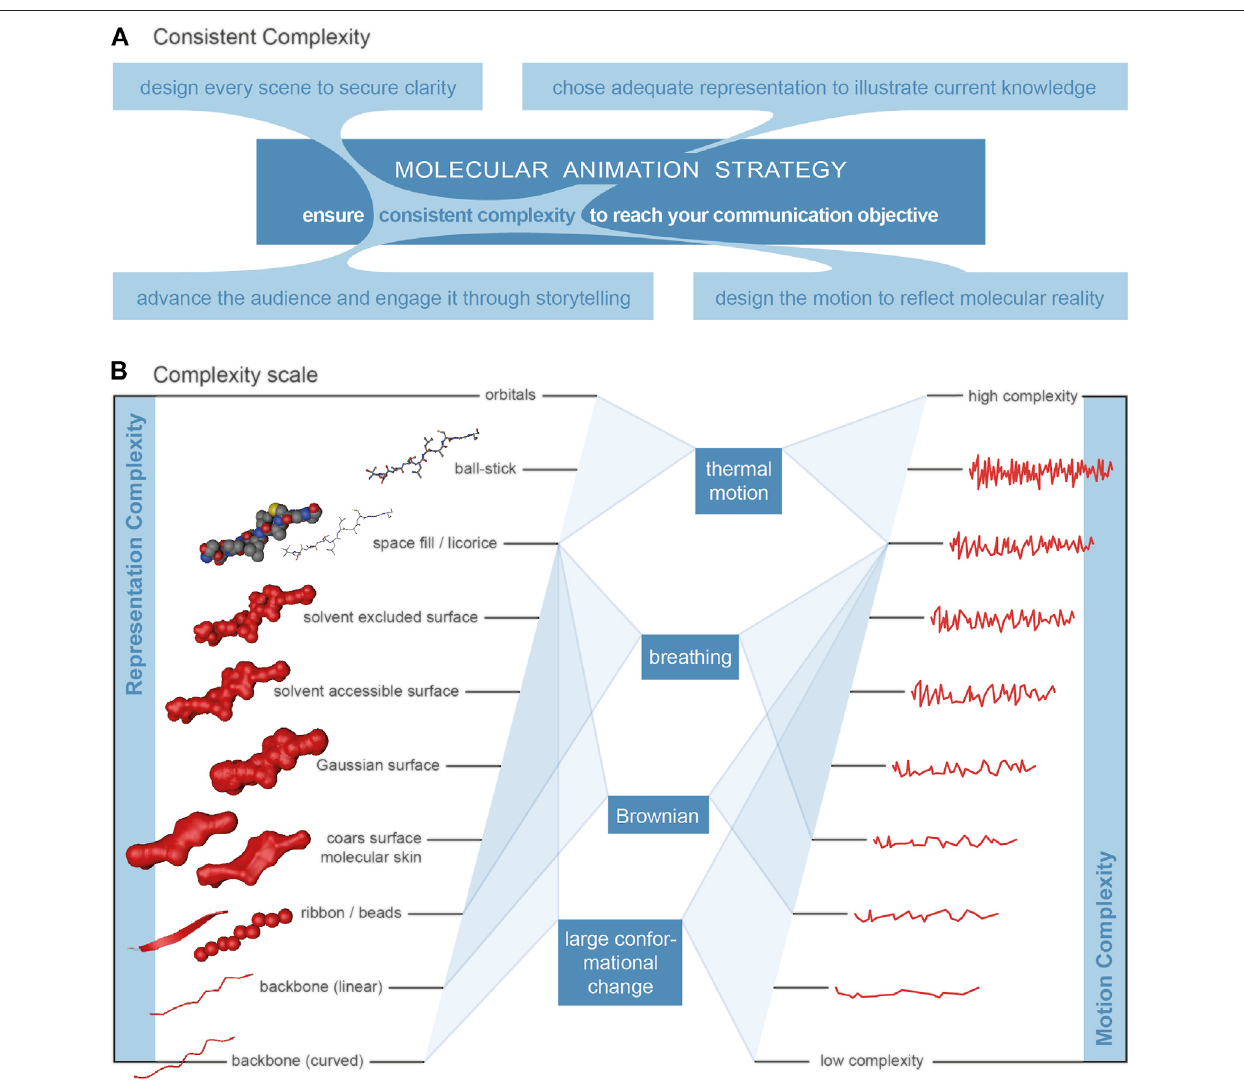
FIGURE 2 | Complexity. (A) Visualisation of the overarching principle for the production of molecular animations, connecting the four main elements audience, design, representation and motion. (B) Relationship between the level of detail of a macromolecule representation and the motion complexity for four relevant types of motion. The complexity of motion (on the right) is visualised by a waveform-like line where a higher frequency represents more frequent changes and therefore higher complexity. Representations, level of detail (left). Selected representations of a beta-sheet poly-peptide on a scale of increasing level of detail/complexity from the bottom tothe top.Illustrativeabstract representations: curvedbackbone, linearbackboneand ribbon/cartoon(Richardson,1985;Carson, 1987).Surfaceabstractions: beads and coarse approximation (Blinn, 1982). Atomistic surface representation: molecular skin surface (MSS), Gaussian surface, solvent accessible surface (SAS) (Sanner,etal.,1996)andsolventexcludedsurface(SES)(Connolly,1983).Atomisticspace- fi llingrepresentation:space- fi ll(CoreyandPauling,1953;Koltun,1965aand; Koltun, 1965b). Atomistic bond-centric representations: licorice, ball-and-stick (Fieser,